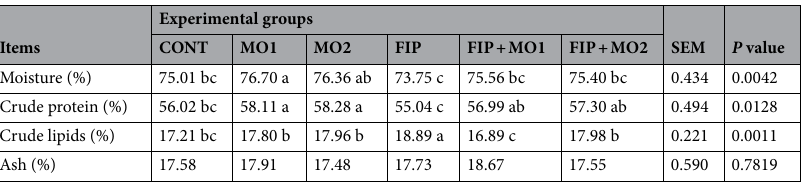
Table 3. Whole body composition (% on dry weight basis) of Nile tilapia groups during the present study. Data represent means ± S.E.M—means having different letters in the same row are significantly different at P < 0.05.